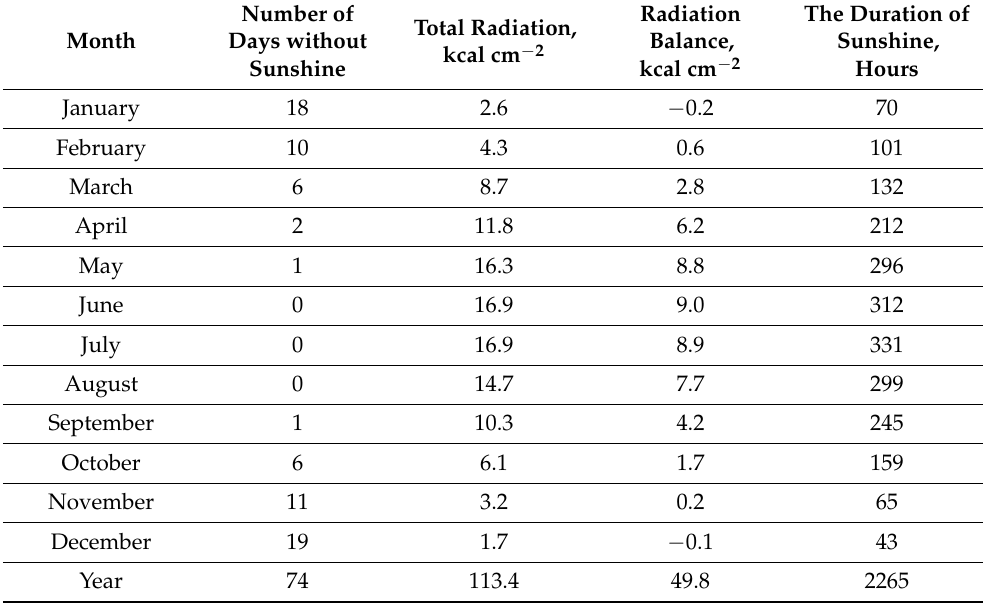
Table 1. Solar radiation in the Lower Volga region *.